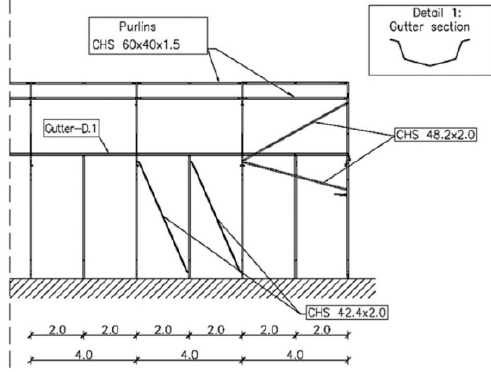
Figure 9. Longitudinal view of the vaulted greenhouse [14].